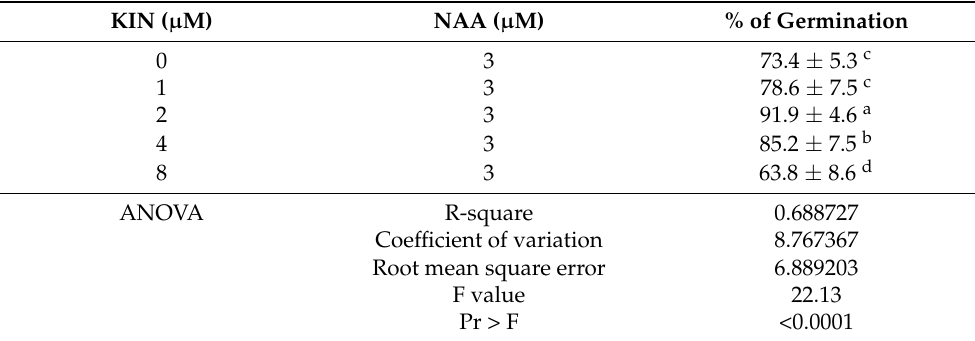
Table 4. Effect of KIN (1–8 µ M) and NAA (3.0 µ M) on seed germination.